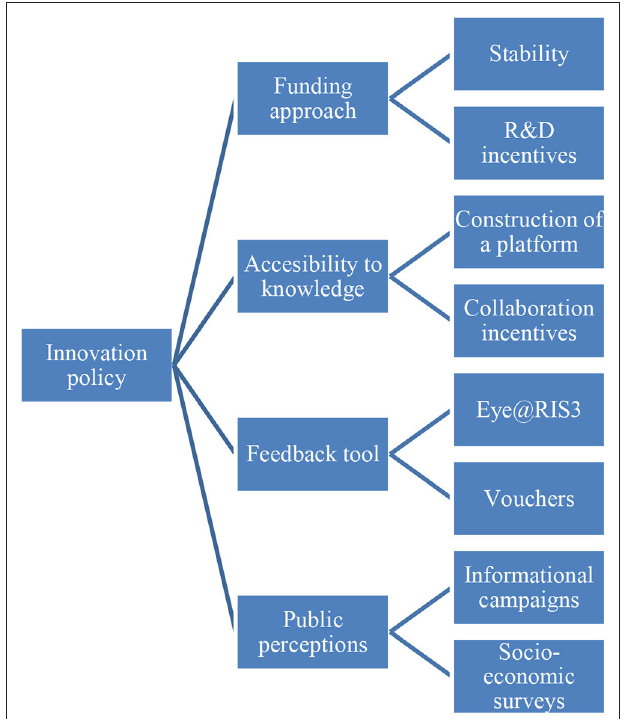
FIGURE 3 | Cluster policy: quadruple axis of innovation policy.